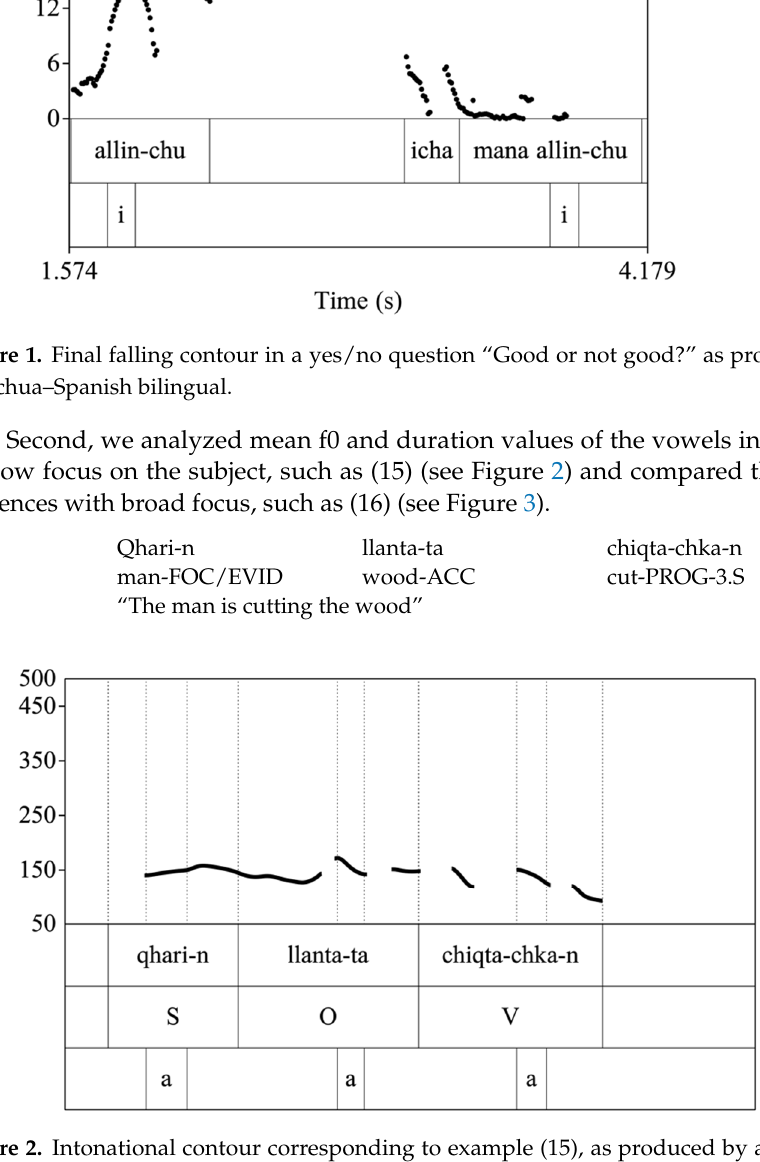
Figure 3. Intonational contour corresponding to example (16), as produced by a female speaker of Cusco Quechua. These sentences were obtained using a contextualized elicited imitation task in which participants saw a picture and listened to a pre-recorded question and a pre-recorded an- swer. They were then asked to provide an acceptability judgment for the answer sentences and then say the sentence the way they would say it. To elicit acceptability judgments and elicited imitations of sentences with narrow focus on the subject, as the example in (15), participants heard the question ‘Who is cutting wood?’ and an answer to that question,